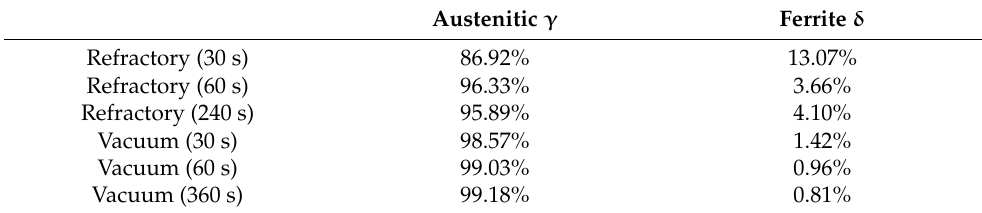
Table 3. The a ustenitic γ FCC microstructure is the dominant phase in both sintered